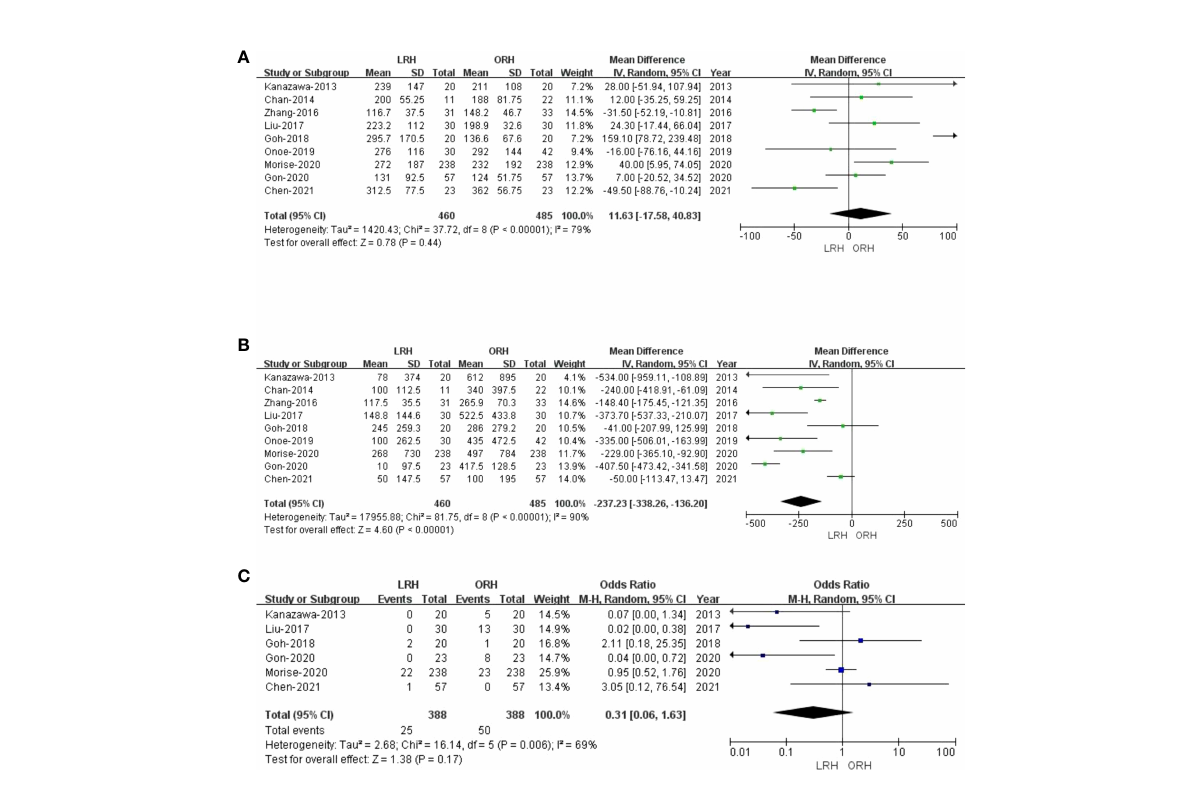
FIGURE 2 Forest plot of comparison of LRH versus ORH for operative outcomes of survivors. (A) , Forest plot for operative time; (B) , Forest plot for bleeding volume; (C) , Forest plot for blood transfusion.